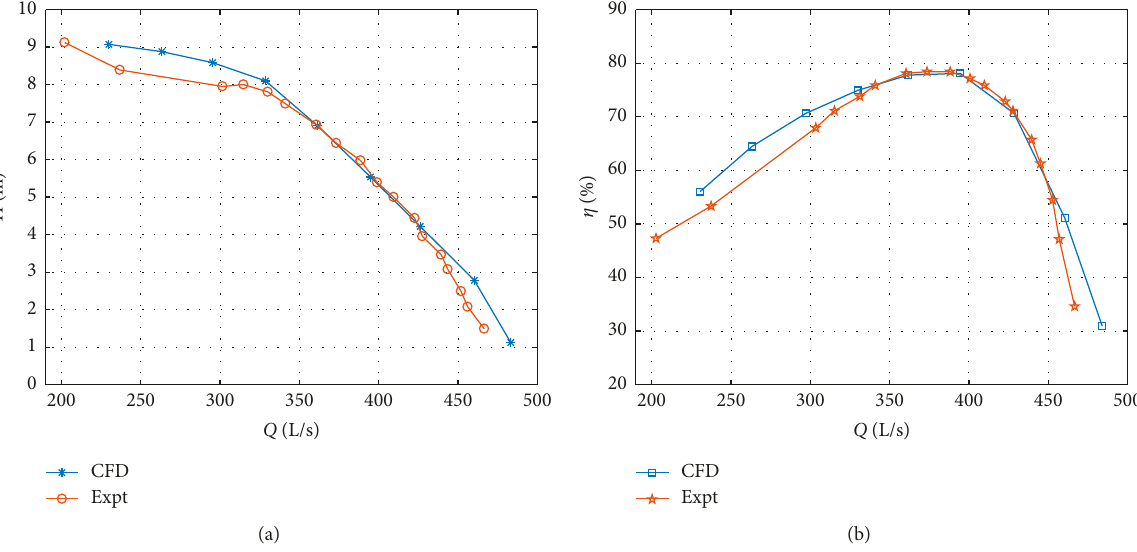
Figure 11: Comparison of model pump test data with numerical simulation data. (a) Head curve. (b) Efficiency